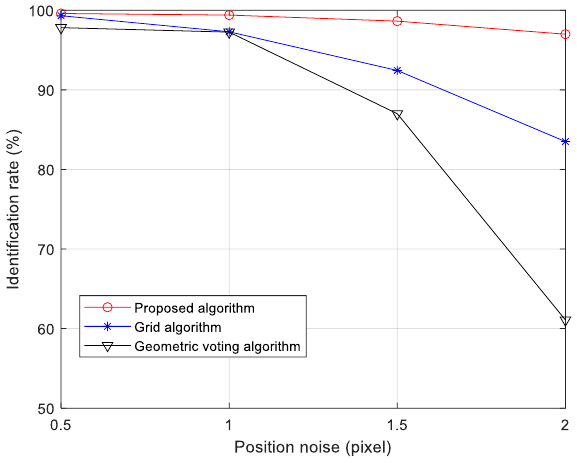
Figure 12. Identification rate versus positional noise.